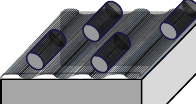
Figure 10. Schematic of the pre-alignment layer (blue), which anchors the LC molecules in the direction of the grooves being rubbed into the polyimide film with a velvet cloth.